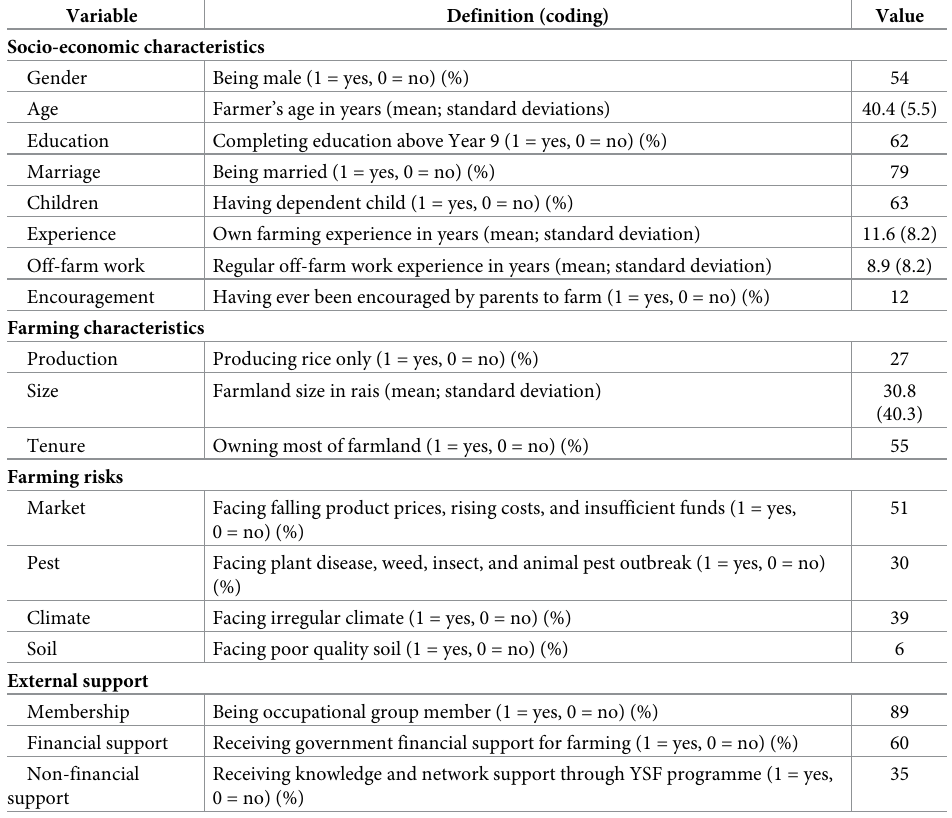
Table 1. Definition and descriptive statistics of independent variables to be considered for inclusion in the models (n =